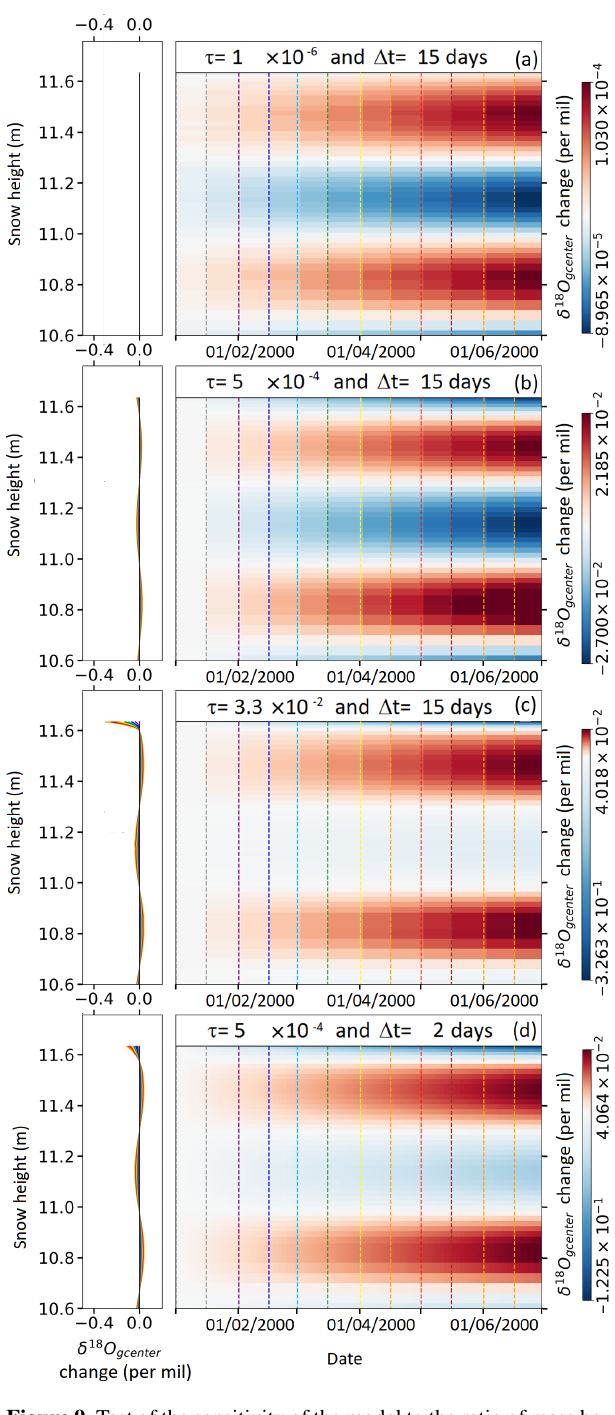
Figure 9. Test of the sensitivity of the model to the ratio of mass be- tween grain surface compartments and total grain and to the interval of mixing between the two compartments